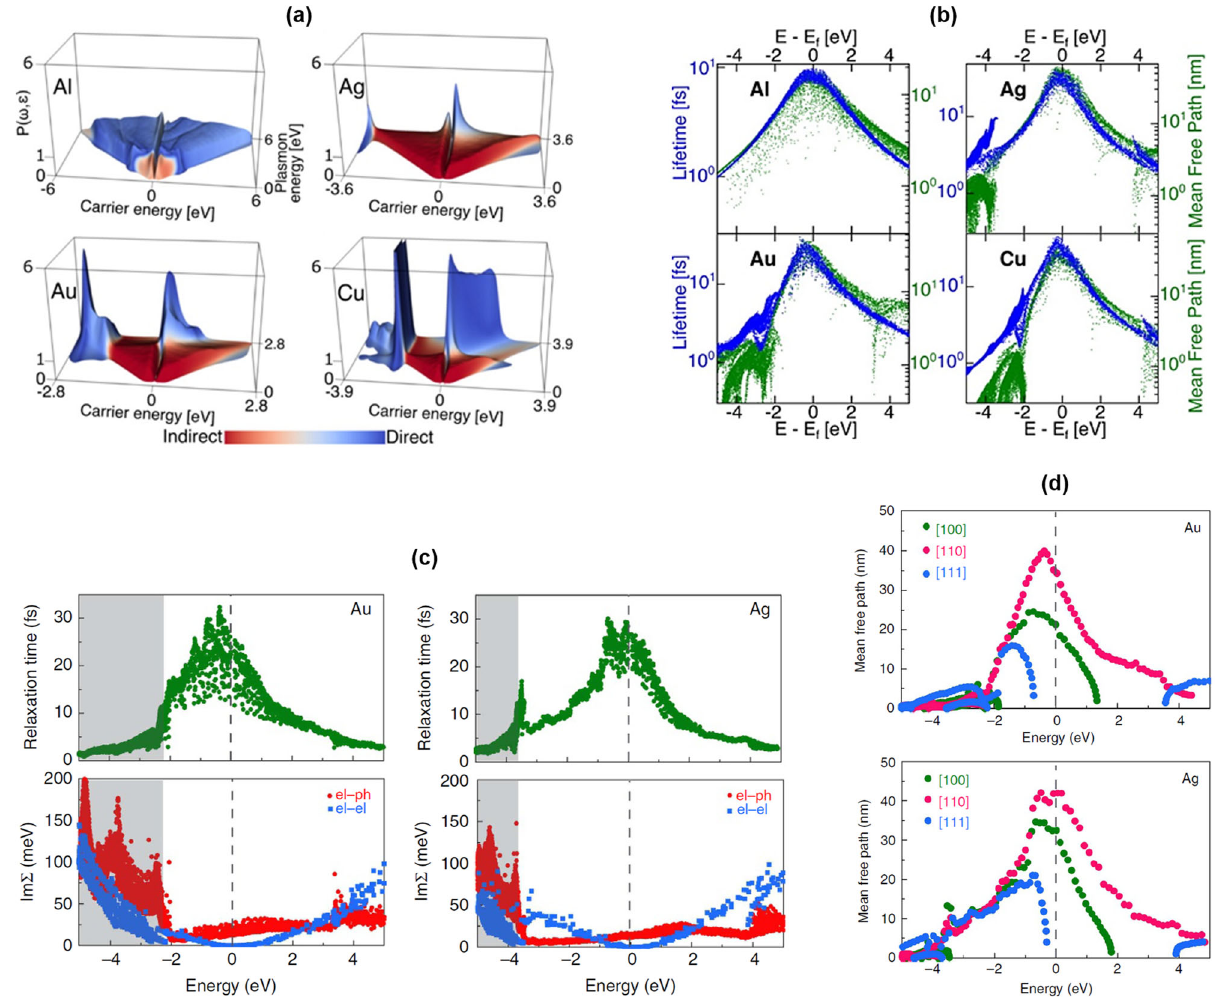
Fig. 3 Energy distribution, lifetime, mean free path, and scattering rates of charge carriers. a The Energy distribution of charge carriers, P( ω , ε ) in Al, Ag, Au, and Cu metals as a function of plasmon frequency, ω , and carrier energy, ε . b Lifetime and mean free path of charge carriers considering electron – electron and electron – phonon scattering ( a , b reprinted with permission from ref. 3 Copyright © 2016, American Chemical Society). c Relaxation time and scattering rates for charge carriers, where scattering rate is expressed as the imaginary part of the self-energy, Im Σ for electron – electron and electron – phonon scattering. The grey shaded area indicates the energy of d-bands. d The mean free path of charge carriers along [100], [110], and [111] crystallographic directions, highlighting isotropic mean free path for s -state and anisotropic for d -states ( c , d reprinted from ref. 26